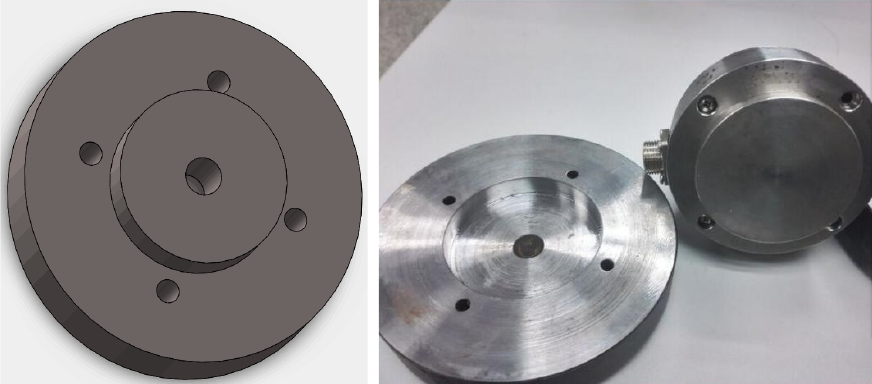
Figure 4. Designed model and picture of the seat for the ultrasonic wave probe.